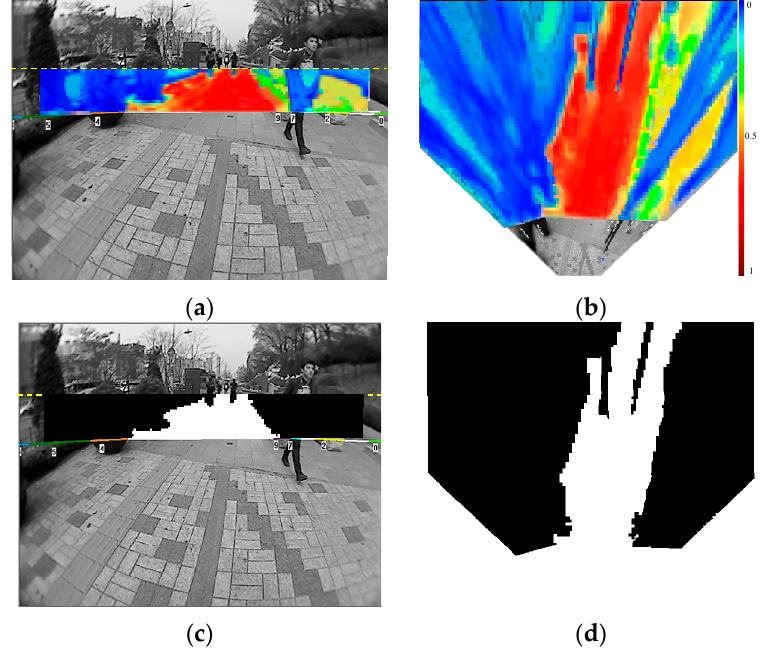
Figure 13. ( a ) Far-field ground probability map on the original image; ( b ) Far-field ground probability map on the top-view image; ( c ) Far-field scene interpretation on the original image; ( d ) Far-field scene interpretation on the top-view image.